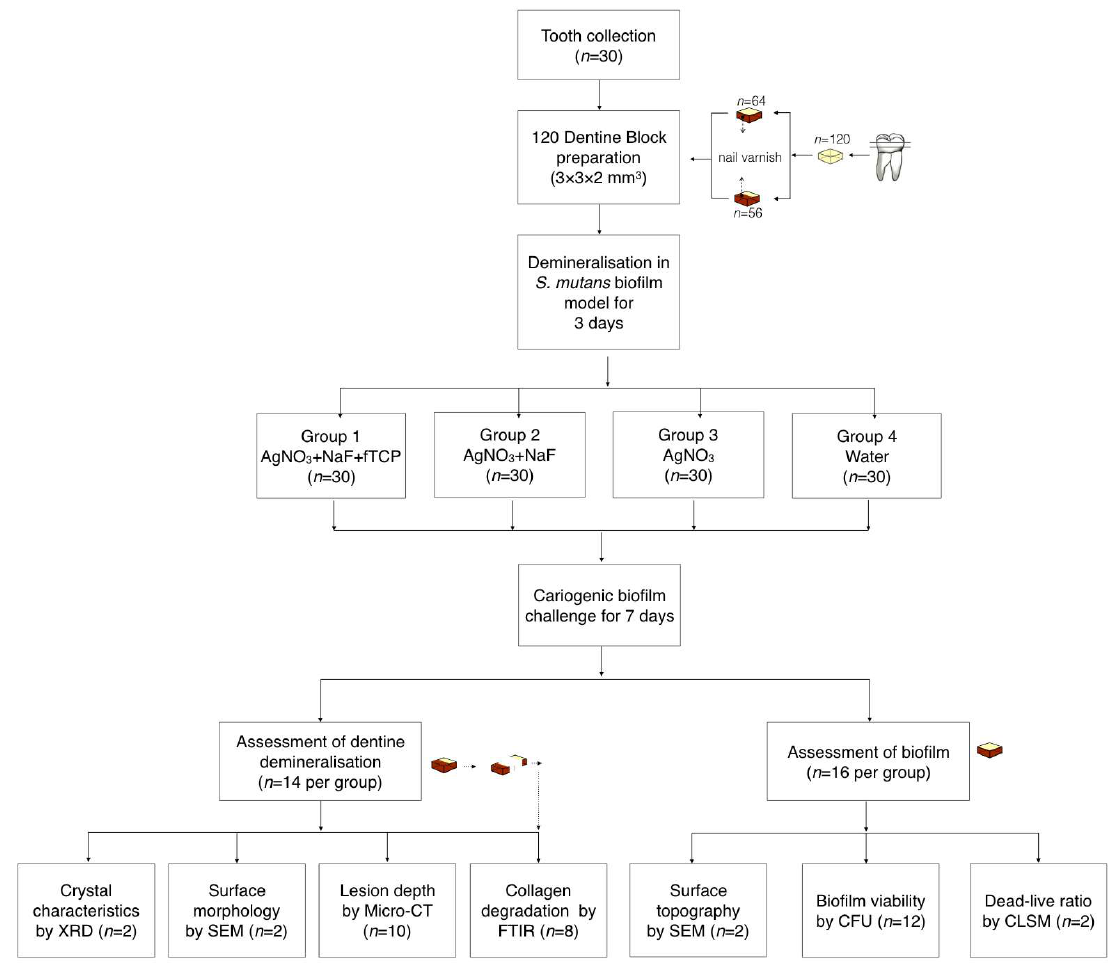
Figure 5. Flow chart of the study.